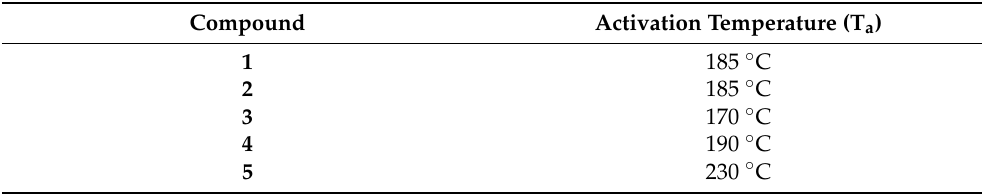
Table 1. Detected activation temperatures of 1–5